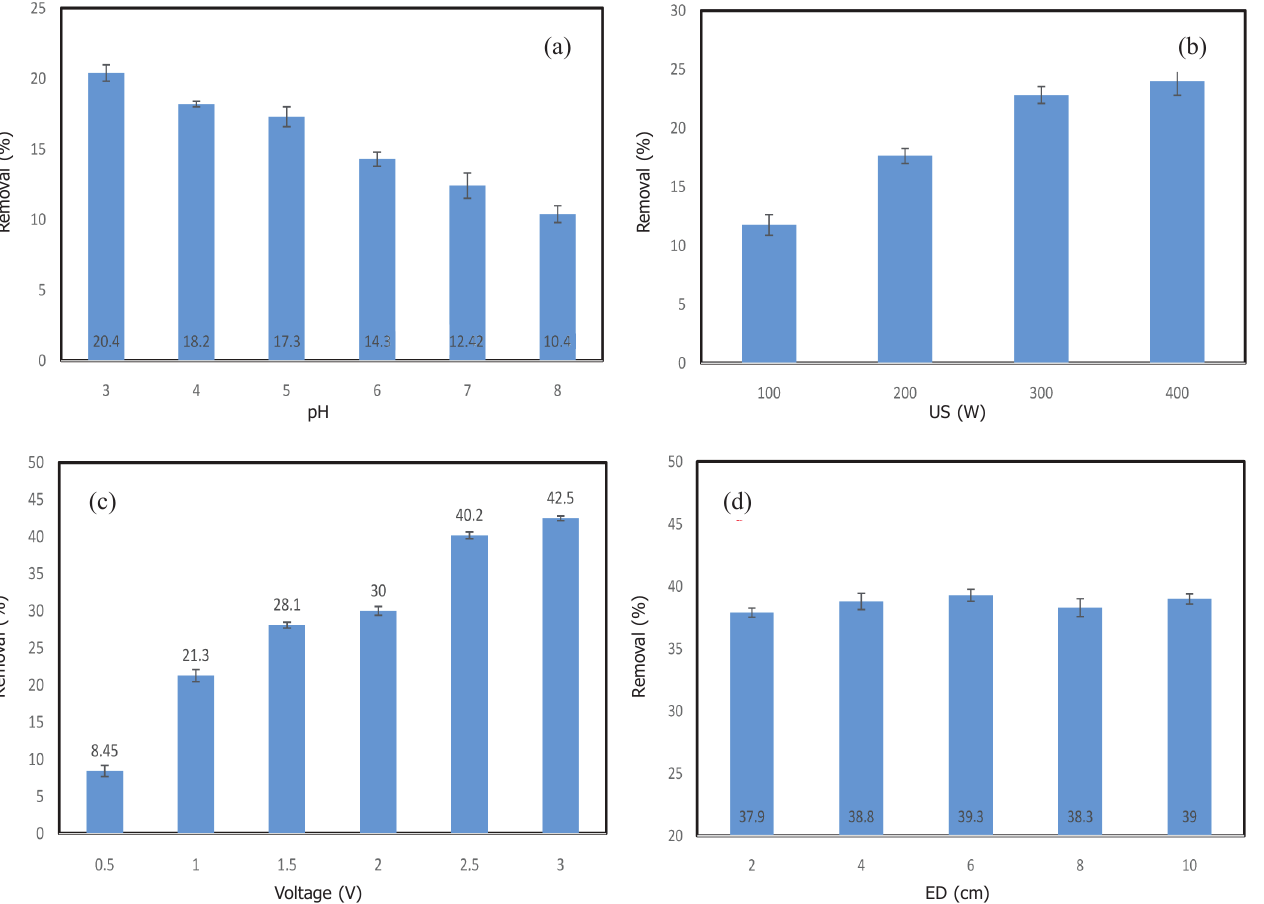
Fig. 2 – a) Effect of pH on COD removal of real saline oily wastewater (initial COD: 4100 mg L –1 , voltage: 1 V, electrode distance 8 cm, reaction time 2 h); b) Effect of sonication (pH: 5, COD: 4250 mg L –1 , voltage: 1 V, electrode distance 8 cm, reaction time 2